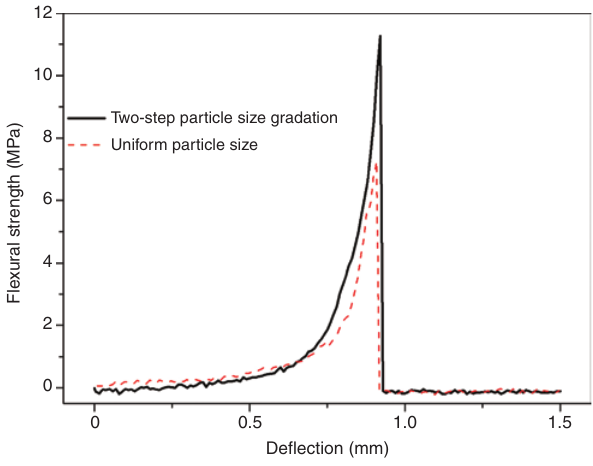
Figure 2 Typical testing curves of Group A and Group B samples.